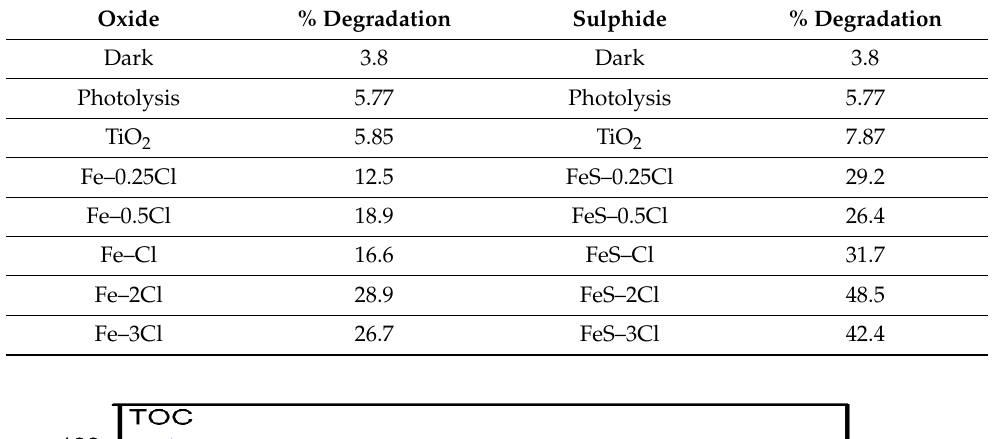
Figure 13. Phenol degradation with oxide and sulphide catalyst.